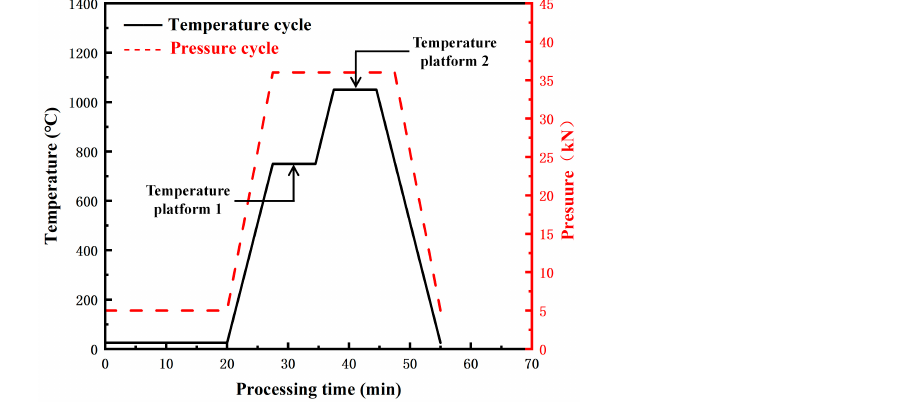
Figure 2. Illustration of the applied temperature and pressure sintering profile.